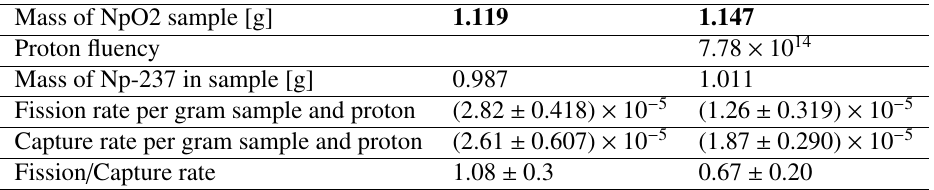
Table 1. Compilation of incineration rate and capture rate of Np-237 samples with proton beams of